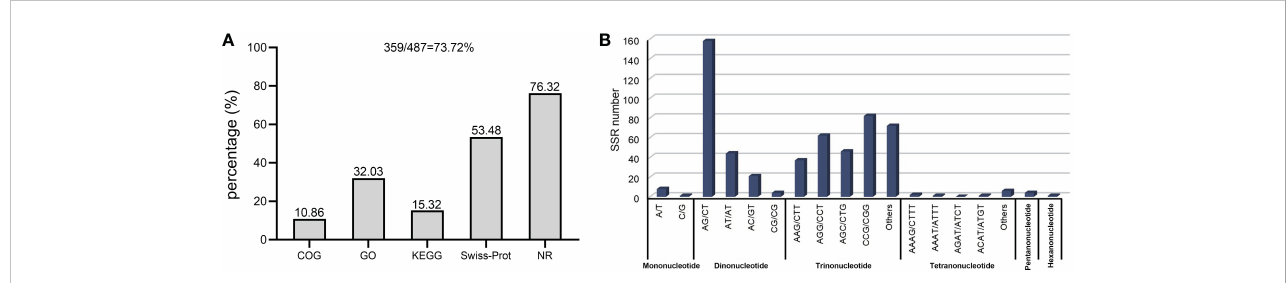
FIGURE 2 Functional annotation (A) and identi fi cation of SSR motif (B) in transcriptome-derived homology unigenes of three varieties though CandiSSR